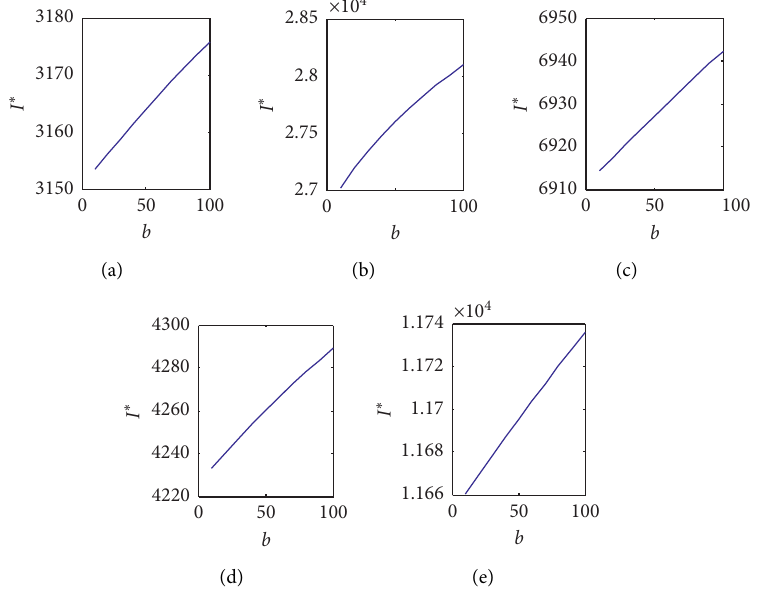
Figure 3: b versus I ∗ graph. (a) Problem 1. (b) Problem 2. (c) Problem 3. (d) Problem 4. (e) Problem